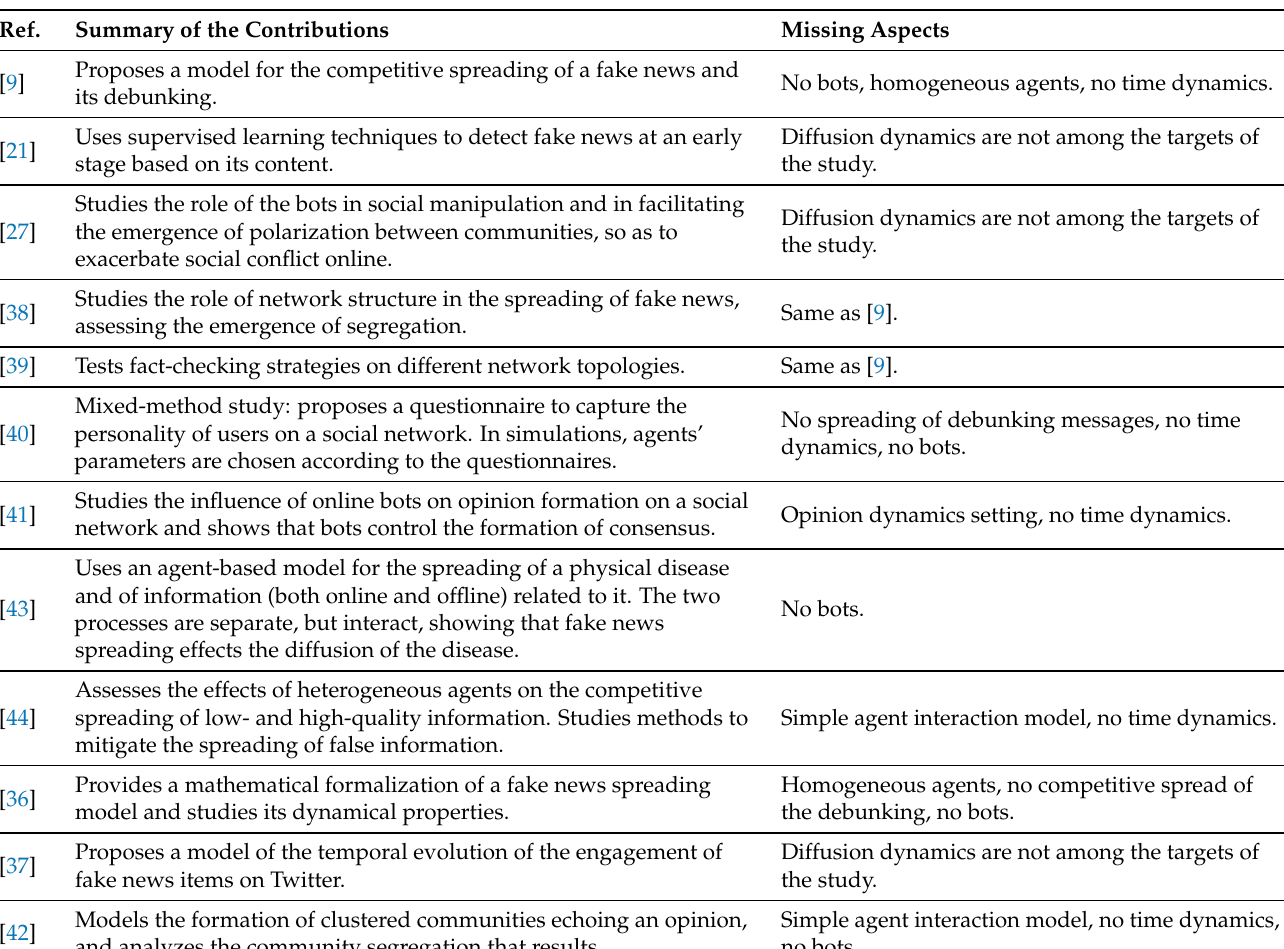
Table 1. Summary of the contributions and missing aspects of the works in the literature that are most related to our agent-based fake news spreading simulation